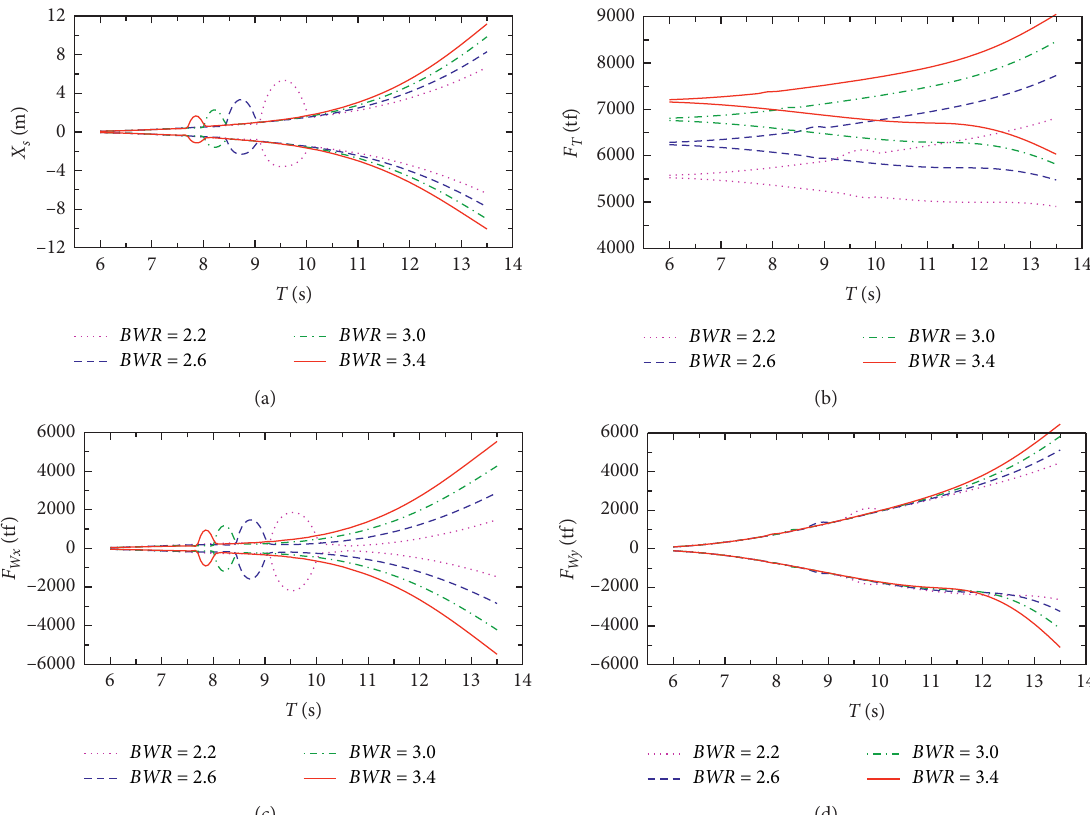
Figure 12: Relevant physical quantities are changed by various wave periods T with different BWR: (a) the horizontal displacement of the tube X s , (b) the mooring cable tension F T , (c) the horizontal wave forces F Wx , and (d) the vertical wave forces F Wy ( s � 0.04; d �